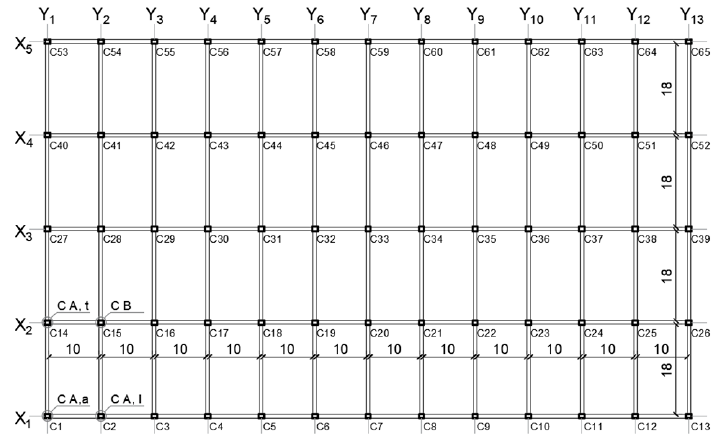
Figure 5. Plan layout of the building.